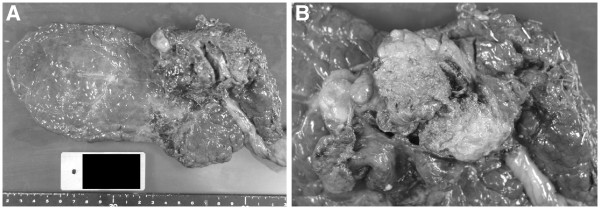
Resected liver (A) and cut surface of the tumor, 4.8 cm maximum diameter (B).